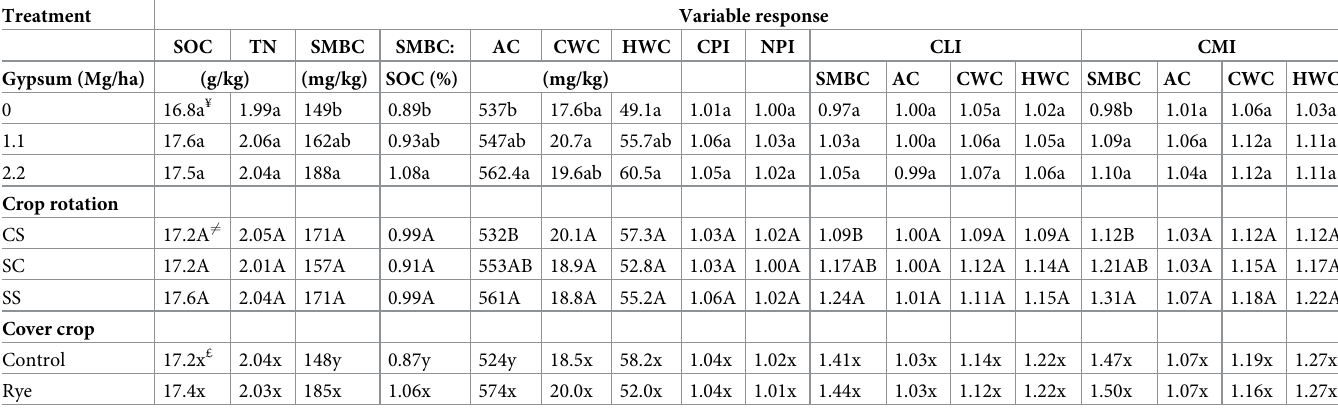
Table 2. Gypsum and cover crop impacts on total soil organic C (SOC), total nitrogen (TN), microbial biomass (SBMC), active carbon (AC), cold (CWC) and hot (HWC) salt water extractable carbon, carbon pool index (CPI), nitrogen pool index (NPI), carbon lability index (CLI), and carbon management index (CMI) under different phases of a rainfed no-till soybean-corn rotation in Ohio-Hoytville (2012 to 2016). Treatment